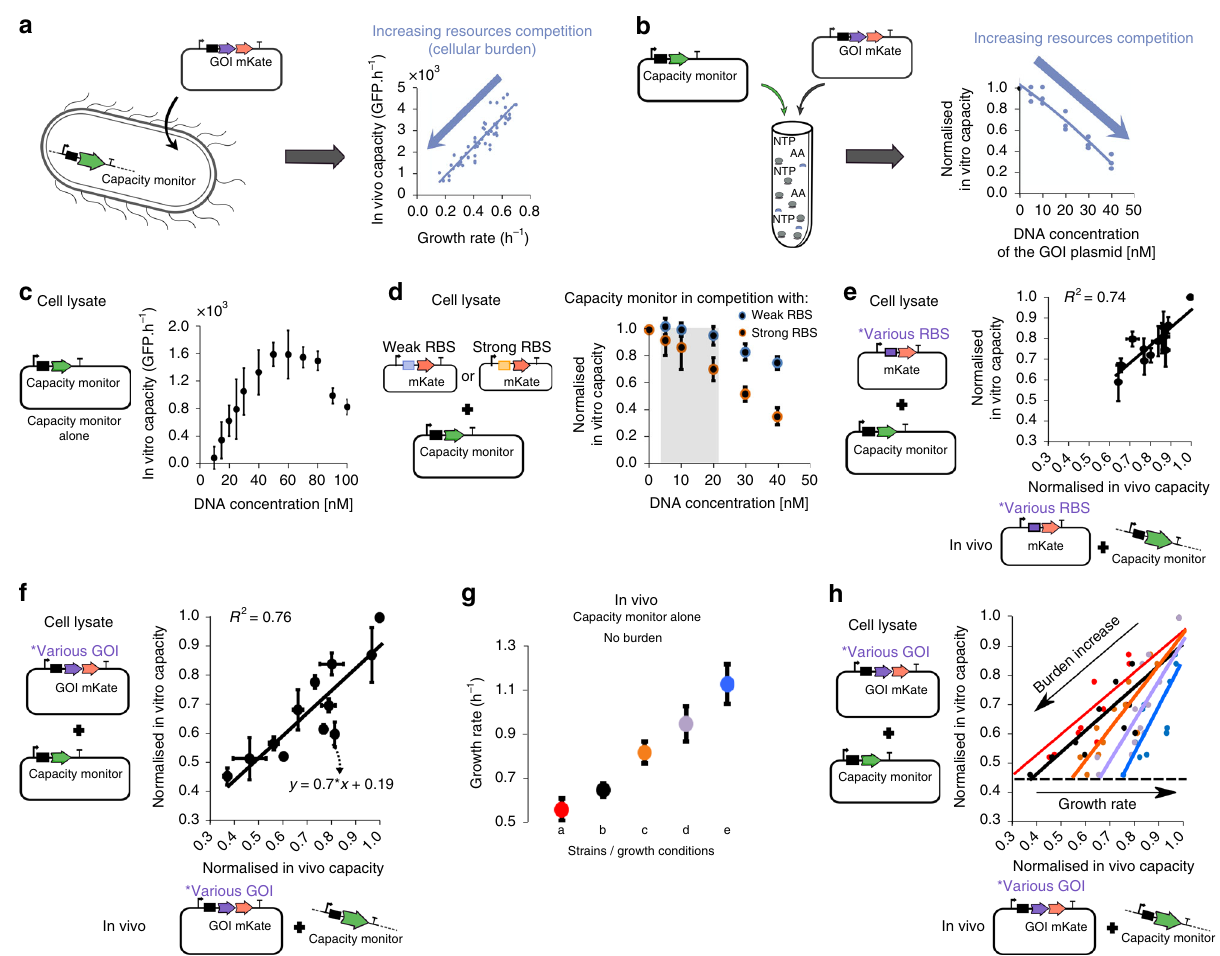
Fig. 1 A method to measure resource competition using a capacity monitor in cell lysate. a Illustration of resource competition in E. coli between a genome- integrated GFP capacity monitor gene and a plasmid-based gene of interest (GoI) fused to mkate . Graph shows the correlation between the inferred expression capacity (measured as max GFP production rate per cell) and the cell growth rate. b Illustration of resource competition in cell lysates expressing the capacity monitor from a plasmid and the GoI from another plasmid. Graph shows the correlation between the normalized in vitro capacity (measured as max GFP production rate, Supplementary Fig. 1A) and increasing concentrations of a GoI plasmid. c Measured in vitro capacity with the capacity monitor plasmid added at different concentrations in cell lysate. d Normalized in vitro capacity measured in cell lysate containing 30 nM of the capacity monitor plasmid and different concentration plasmids bearing mkate with either a strong (black/orange) or a very weak (black/blue) RBS sequence. The grey area represents the concentration of plasmid where competition is for translational resources. Values are normalised to the in vitro capacity obtained with capacity monitor plasmid alone. e Correlation between normalized in vitro capacity measured in cell lysate and normalized in vivo capacity measured with DH10B cells. The constructs in this experiment all express mkate with different RBS sequences (Supplementary Table 1). f Correlation between normalized in vitro capacity measured in cell lysate and normalized in vivo capacity measured in DH10B using constructs with various genes of different sizes paired with RBS BCD2 64 . g Growth rate of strains growing in different conditions and containing only the capacity monitor. Strains/ conditions: DH10B in M9 pyruvate (a, red); DH10B in M9 fructose (b, black); MG1655 in M9 fructose (c, orange); DH10B in M9 glucose (d, purple); DH10B in LB (e, blue). h Correlation between normalized in vitro capacity (from f ) and normalized in vivo capacity when constructs with various genes of different sizes paired with RBS BCD2 are expressed in the strains and conditions described in g . Error bars show standard error of three independent